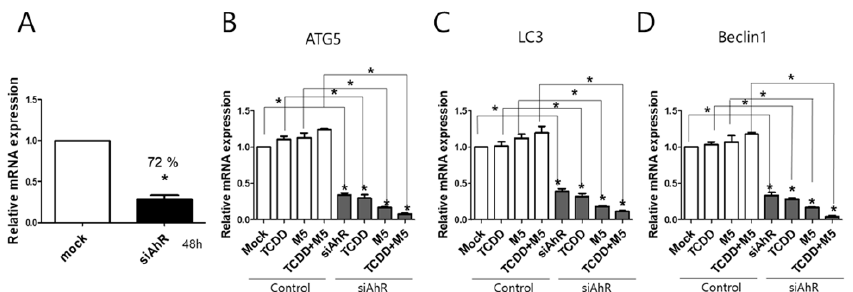
Figure 5. Knockdown of AhR resulted in significant attenuation of autophagy-related markers. ( A ) siRNA oligonucleotide targeting AhR was tested using qPCR. ( B–D ) HaCaT cells were transiently transfected with AhR siRNA and stimulated with TCDD (10 nM) in the presence of M5 (10 ng / mL) for 48 h. qPCR analysis was performed for ( B ) ATG5, ( C ) LC3, ( D ) Beclin1 expression. Data represent the mean ± S.D. of three independent experiments (each performed in duplicate). Statistical analysis was performed by one-way ANOVA test followed by multiple comparison Tukey’s test. * indicates p < 0.05 in comparison to unstimulated